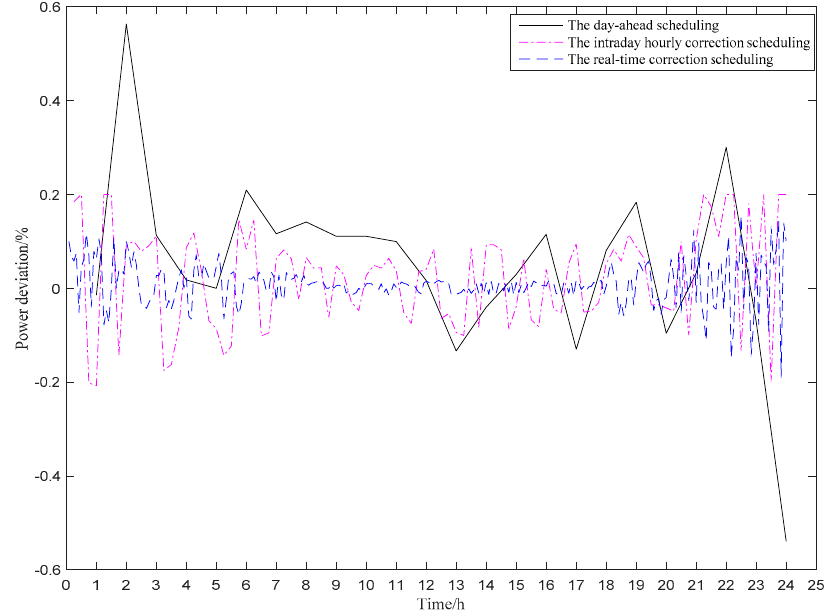
Figure 7. Power deviation percentage of three time-scale scheduling methods benchmarked with an actual system generalized load.